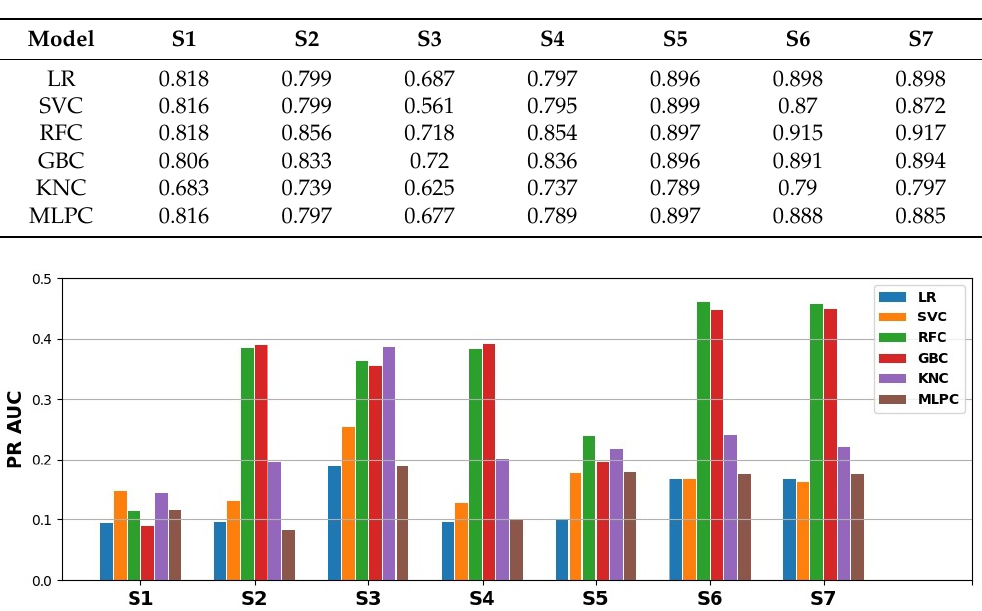
Table 6. ROC AUC values for particular algorithms and attribute subsets.